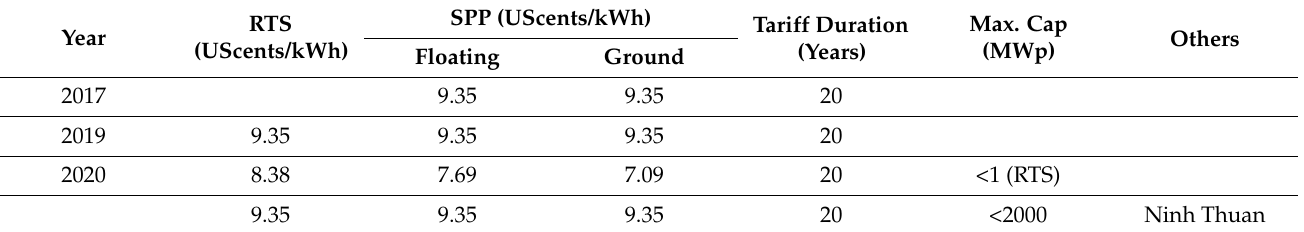
Table 1. The FIT for grid-connected solar PV in 2017–2020. (Adapted from Refs.